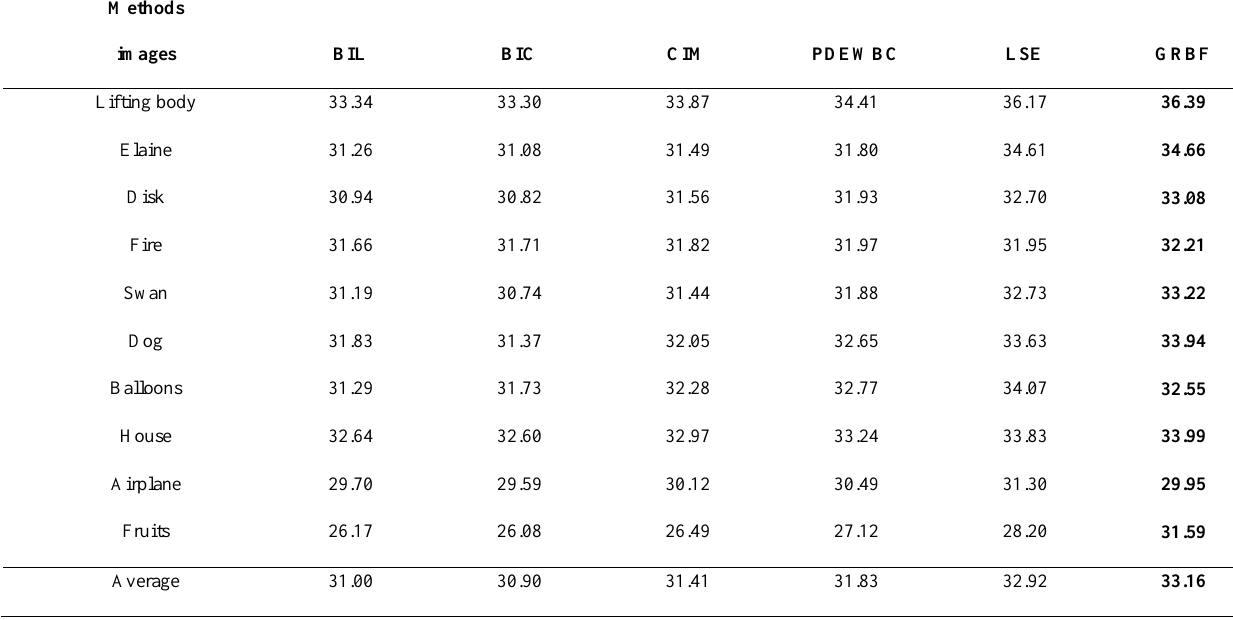
Table 5. Comparison of GRBF and other methods by PSNR criterion by factor of 2 in zooming. Methods